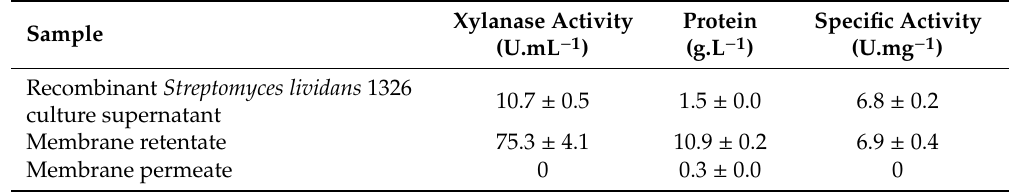
Table 2. Comparison of XYN10Ks_480 endoxylanase activity and protein content before and after nanofiltration (NF) membrane separation.